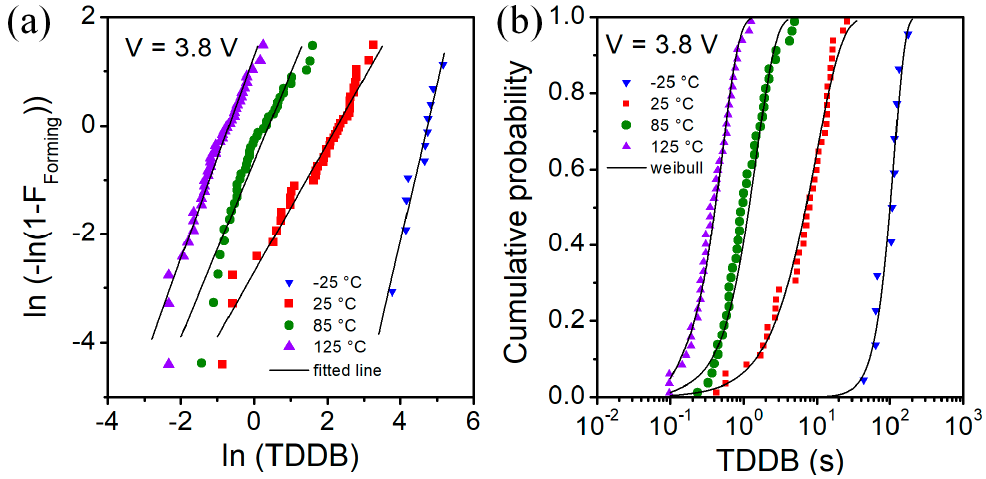
Figure 6. Weibull plot ( a ) and distribution ( b ) of time to breakdown for voltage stress value of 3.8 V and temperature as a parameter.